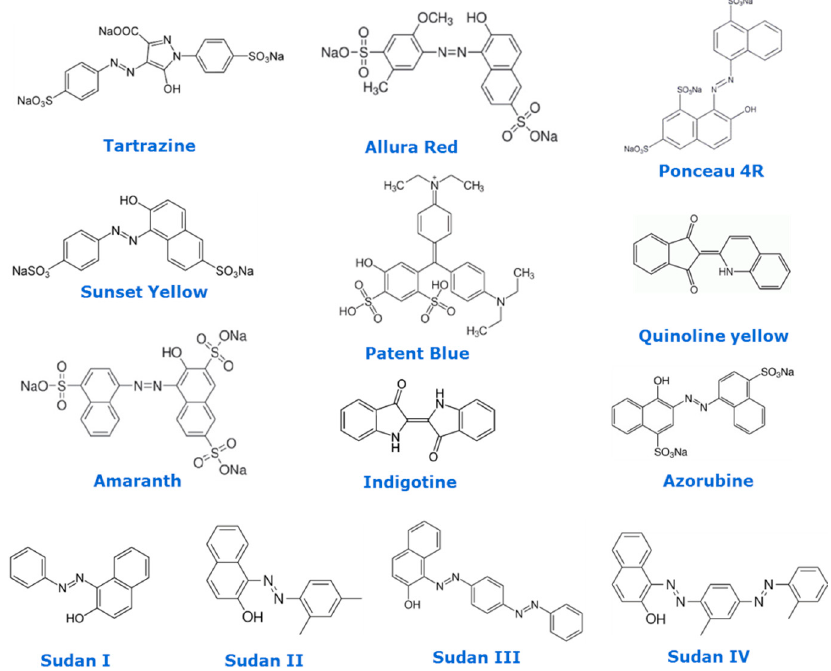
Figure 1. Chemical structures of selected regulated food colorants.